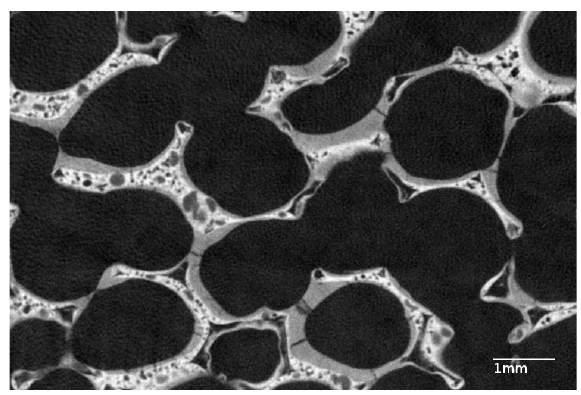
Figure 7. X-ray picture of alumina layer on SiC foam.